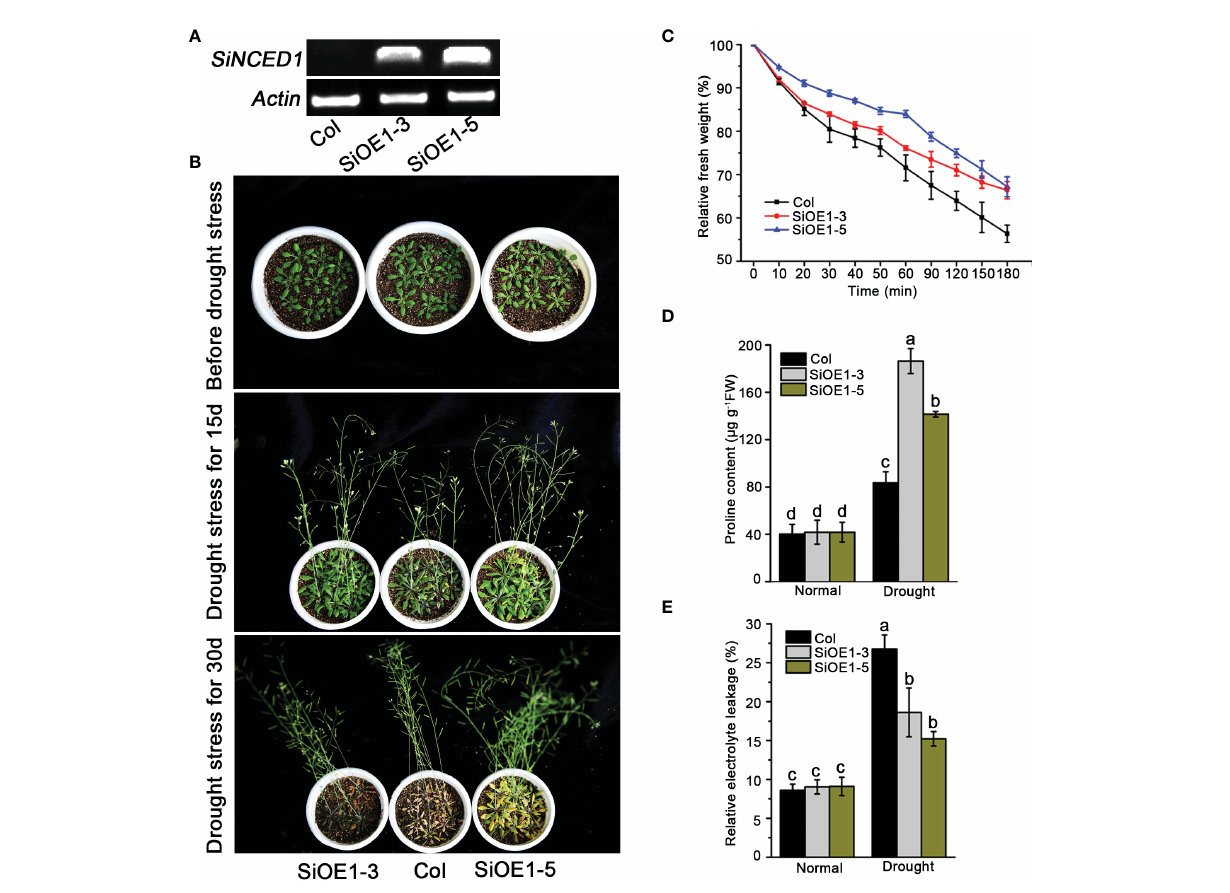
FIGURE 4 Drought stress tolerance of SiNCED1 overexpression plants. (A) Semi-quantitative RT-PCR detection of SiNCED1 expression in Col and SiOE1-3, SiOE1-5. (B) The phenotype of SiNCED1 -overexpressing plants and Col seedlings under drought stress. (C) Measurement of water loss rate in Col and siNCED1- overexpressing seedlings. (D) Proline content determination after drought stress treatment (E) Relative electrolyte leakage determination after drought stress treatment. Data shown are mean ± SD from three independent replicates. Values are the mean ± SD ( n = 6 plants). Similar results were obtained from three independent replicates. Different letters represent signi fi cant differences at P <0.05 (ANOVA analysis, Tukey ’ s multiple comparisons test )